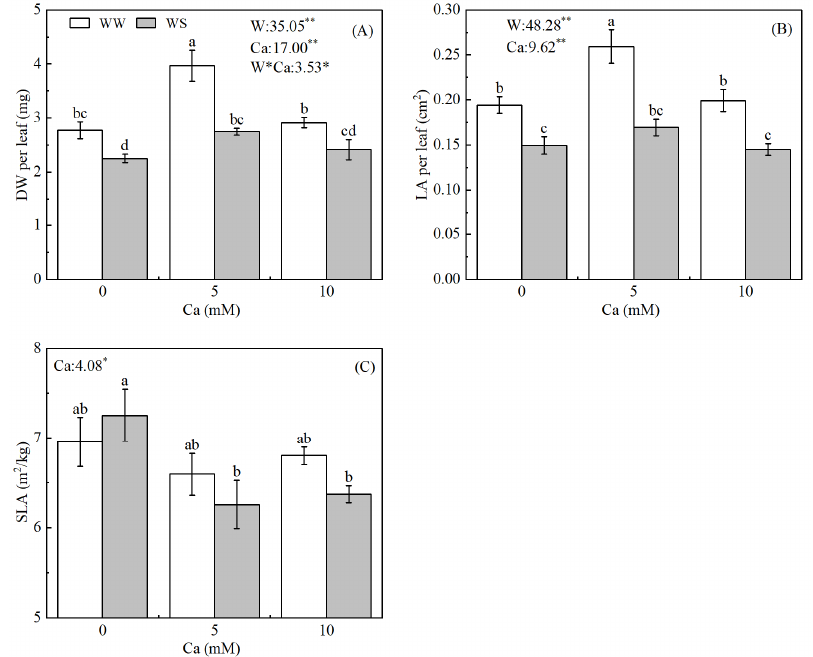
Figure 1. Leaf dry weight (DW, A ), leaf area per leaf (LA, B ), and special leaf area (SLA, C ) of Pinus sylvestris var. mongolica exposed to well water (WW), water stress (WS) and different calcium (Ca) concentration. Different letters indicate significant differences at p < 0.05 determined by Duncan’s multi-range test. F values are provided for the significant effects of the main variables calcium (Ca), water (W) and their interactions, and the single * in the upper right corner indicated a significant effect at 0.05 level, and the double * indicated a significant effect at 0.001 level. F is not provided when Ca, W, and their interactions are not significant.